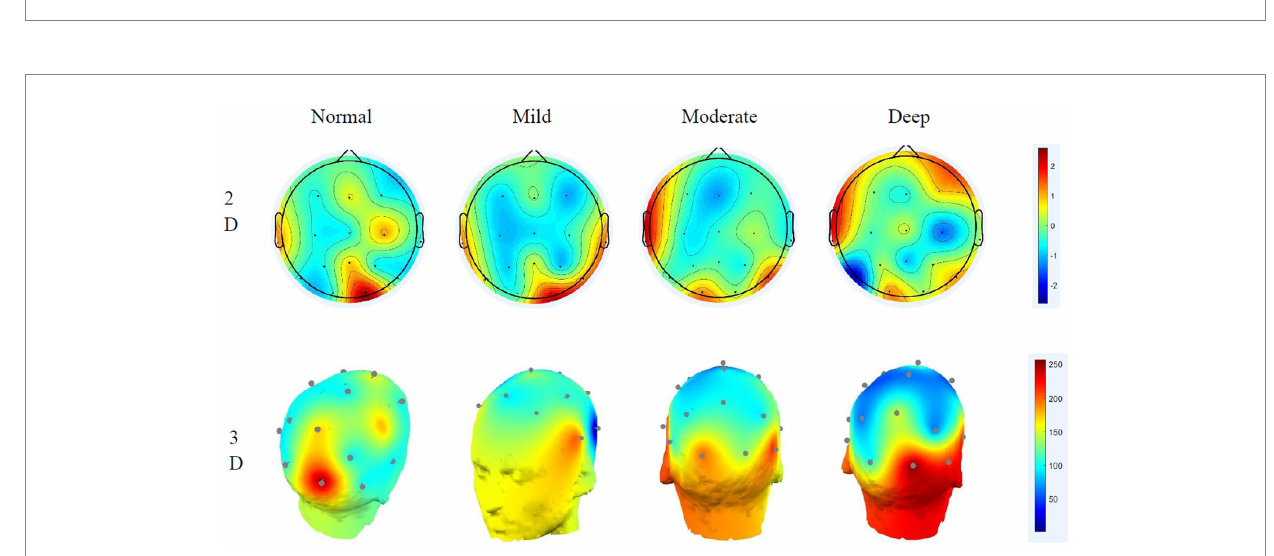
FIGURE 6 Theta wave 2D–3D EEG topography in different